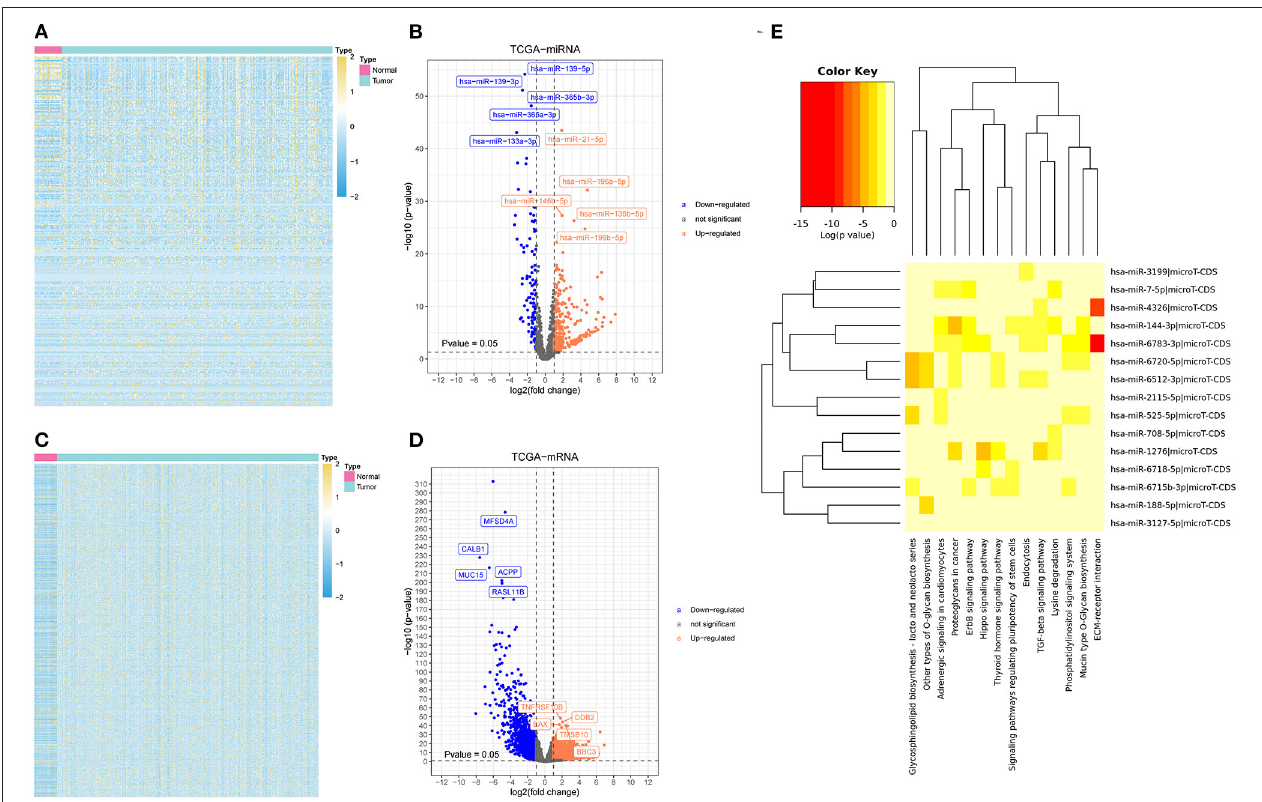
FIGURE 2 | Differently expressed miRNAs and messenger RNAs (mRNAs) (DEmiRNAs and DEmRNAs, respectively) and the possible associated signal pathways (A) a heatmap of DEmiRNAs. (B) A volcano plot of DEmiRNAs. (C) A heatmap of DEmRNAs. (D) A volcano plot of DEmRNAs. (E) The possible signal pathways in which 15 miRNAs may be